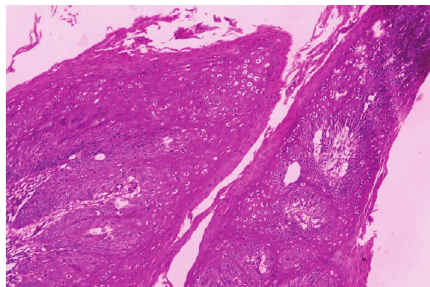
Figure 3: Conspicuous koilocytotic atypia present throughout the tumor (H&E, ×